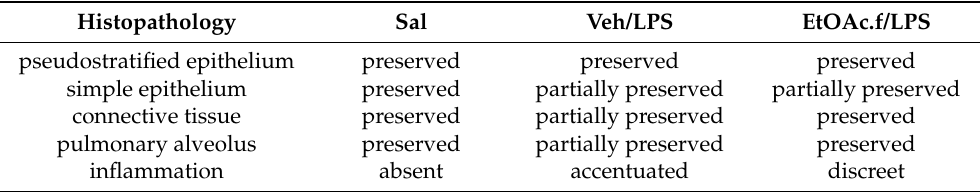
Table 2. EtOAc.f protects against LPS-induced histopathological changes in the lung. Mice were pretreated with oral administration of vehicle (Veh) or EtOAc.f 24 h and 1 h before intranasal challenge with LPS (10 µ g/40 µ L). Following 24 h after LPS instillation, the qualitative morphological analysis